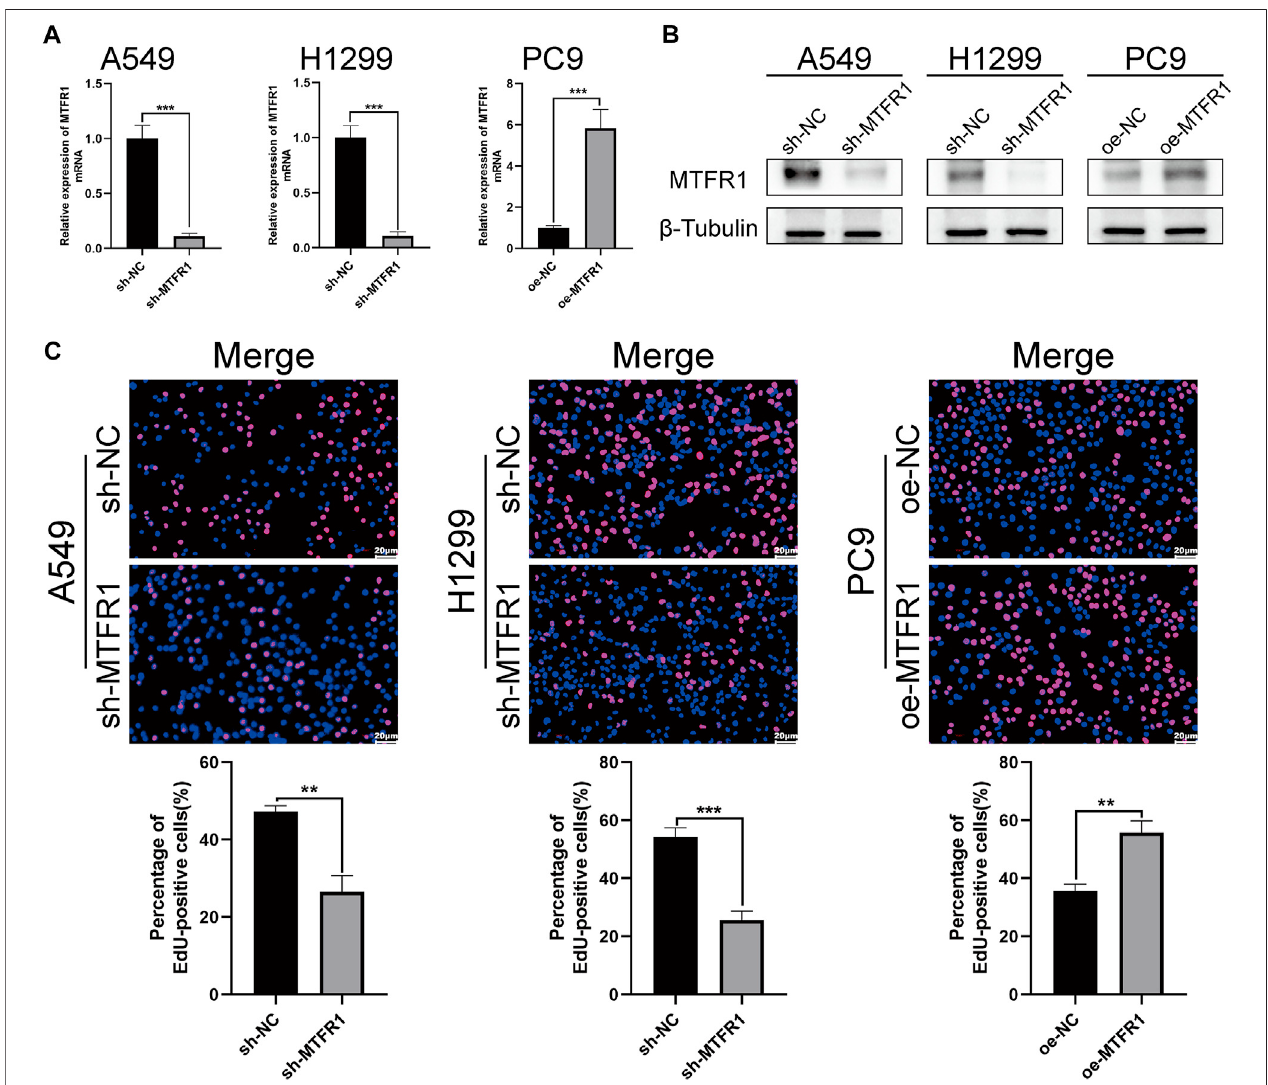
FIGURE 2 | MTFR1 stimulated the proliferation of LUAD cells. (A, B) Evaluation of the effectiveness of lentiviral transduction by real-time quantitative polymerase chain reaction (RT-qPCR) and western blotting (WB). (C) EdU staining of the transduced cells. Data were articulated as the mean ± standard deviation (SD; ** p < 0.01, *** p <